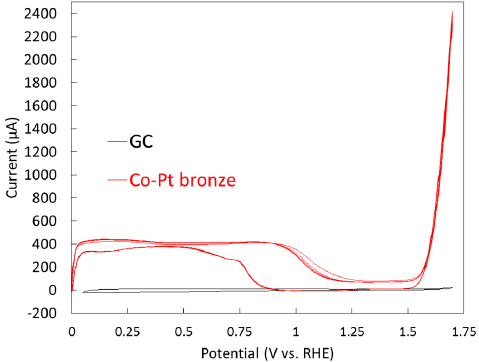
Figure 17. Cyclic Voltammogram of activated Co-Pt bronze showing its HOR and OER activities.